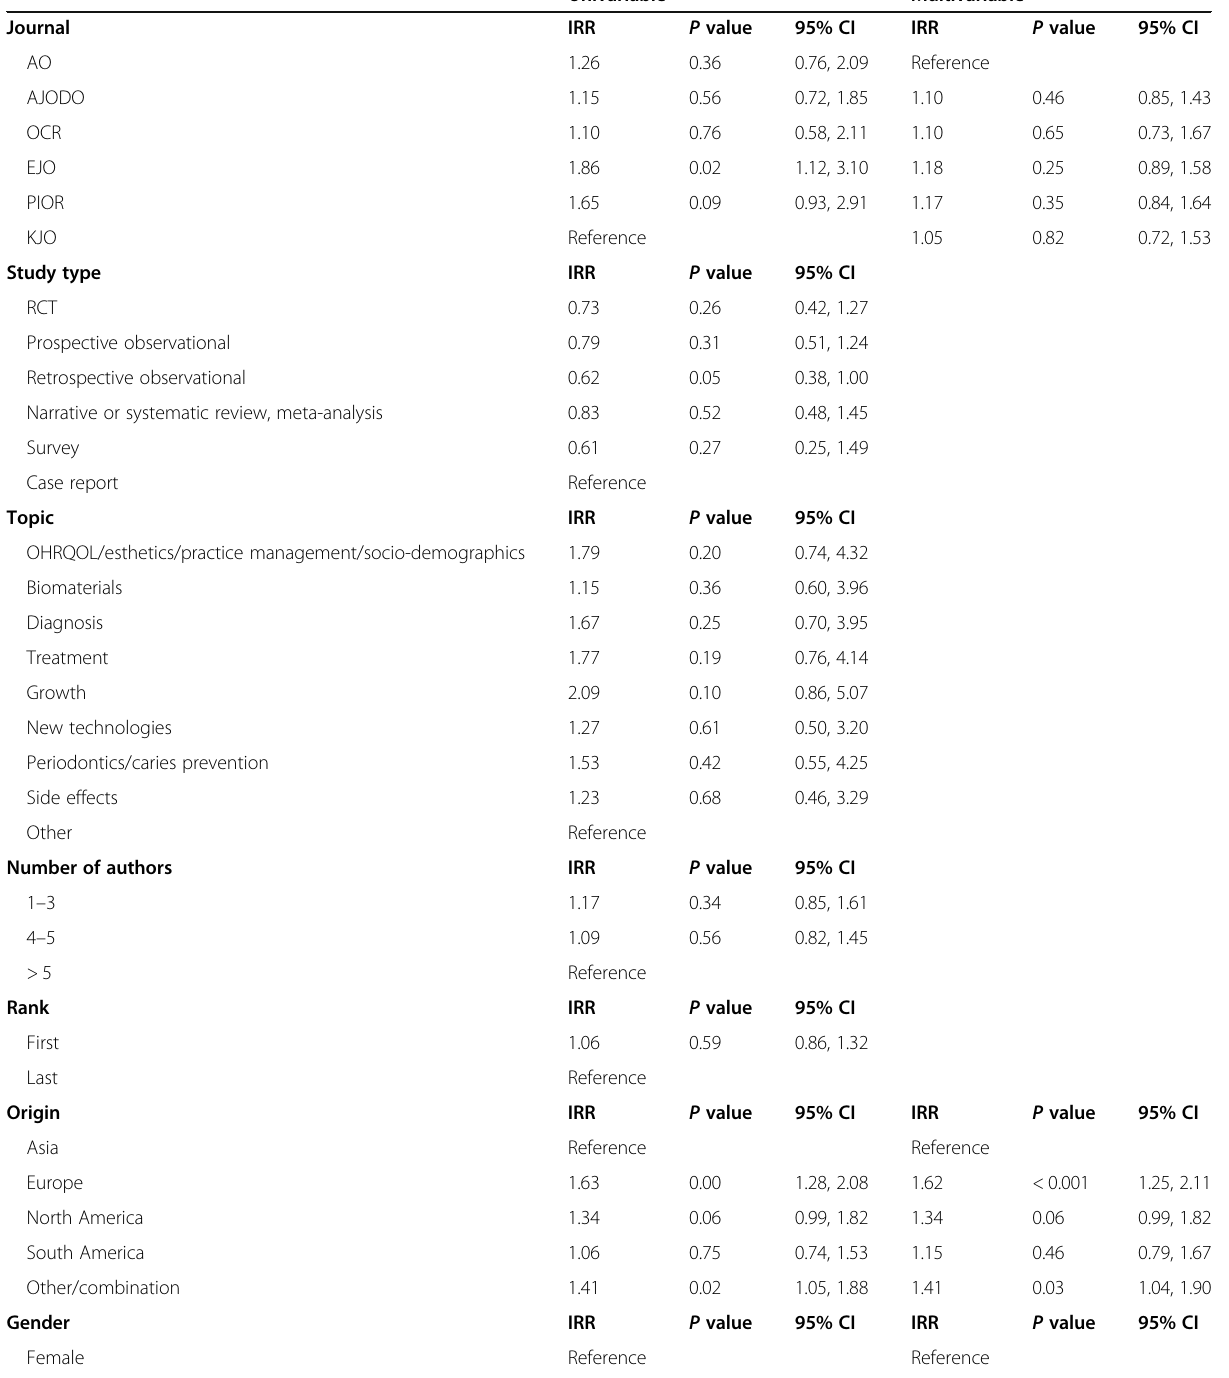
Table 3 Univariable and multivariable negative binomial regression results Univariable